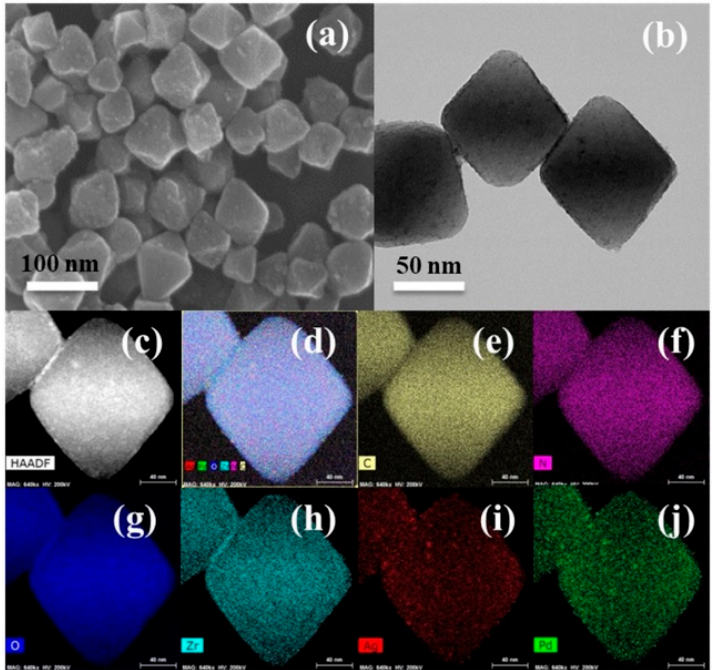
Figure 4. Scanning electron microscopy (SEM) image ( a ), TEM image ( b ), HAADF image ( c ), total element ( d ), and elemental mapping ( e – j ) of AgPd@UiO-66-NH 2 . The bar indicate 100 nm ( a ), 50 nm ( b ), and 40 nm ( c – j ). Reproduced and adapted from Ref. [11]; Copyright (2018), Elsevier Sensors and Actuators B: Chemical.